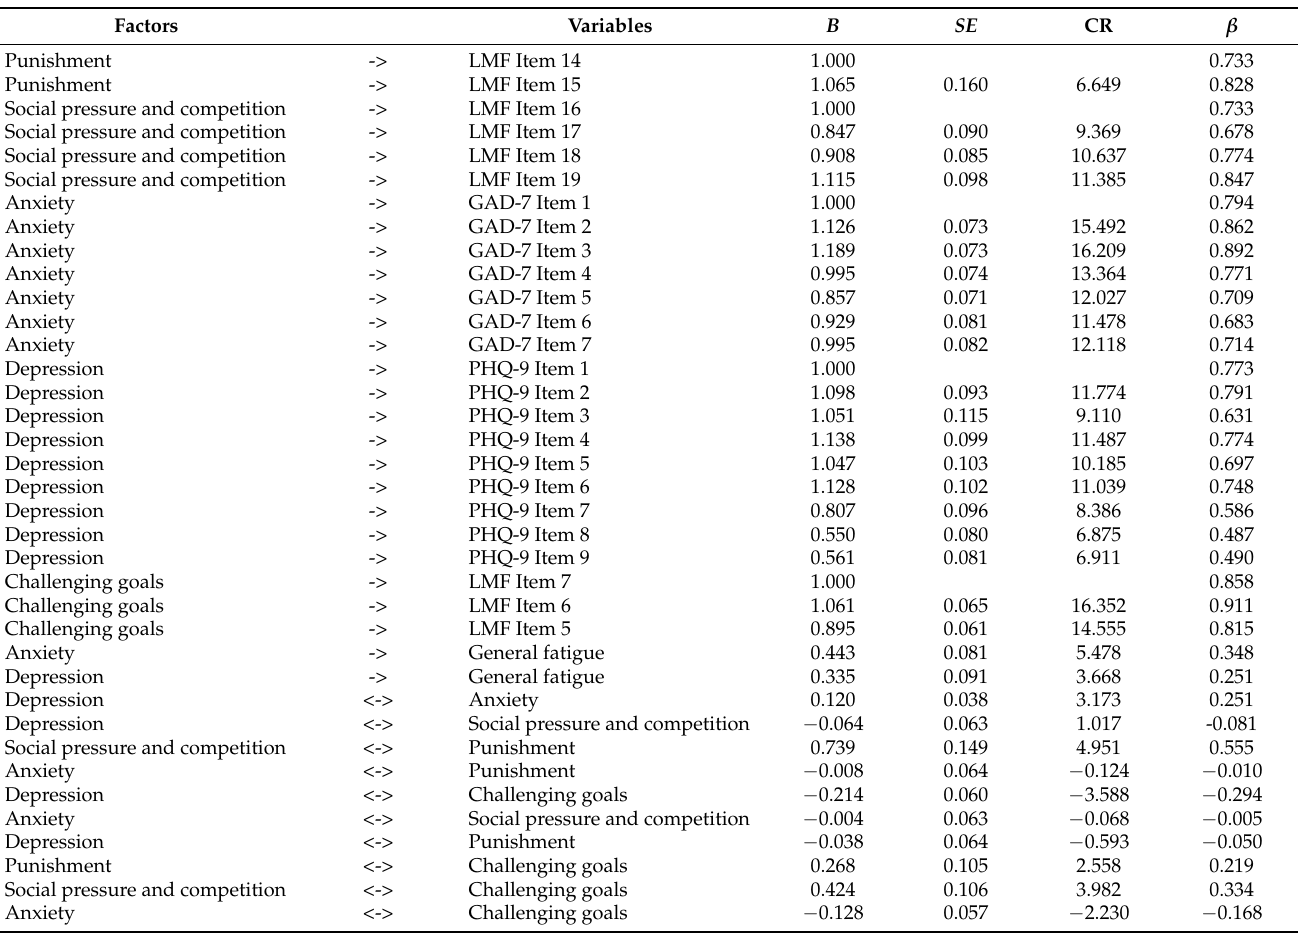
Table 16. Scalar estimates of the model of associations between learning motivating factors, anxiety, depression, and fatigue in the sample of respondents who did not participate in e-learning-based computer programming courses.